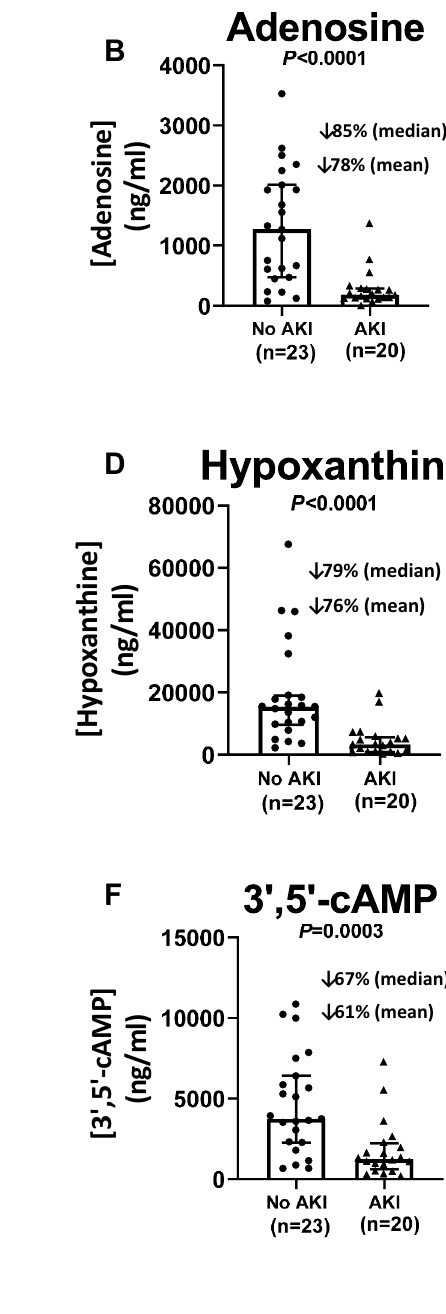
Figure 1. Effects of acute kidney injury (AKI) on urine levels (ng/ml) of ( A ) 5’-AMP, ( B ) adenosine, ( C ) inosine, ( D ) hypoxanthine, ( E ) xanthine and ( F ) 3’,5’-cAMP. Dot plots show individual values. Also shown are medians with interquartile ranges and the percentage decreases ( ↓ %) in both the median and mean values in AKI compared to patients without AKI (No